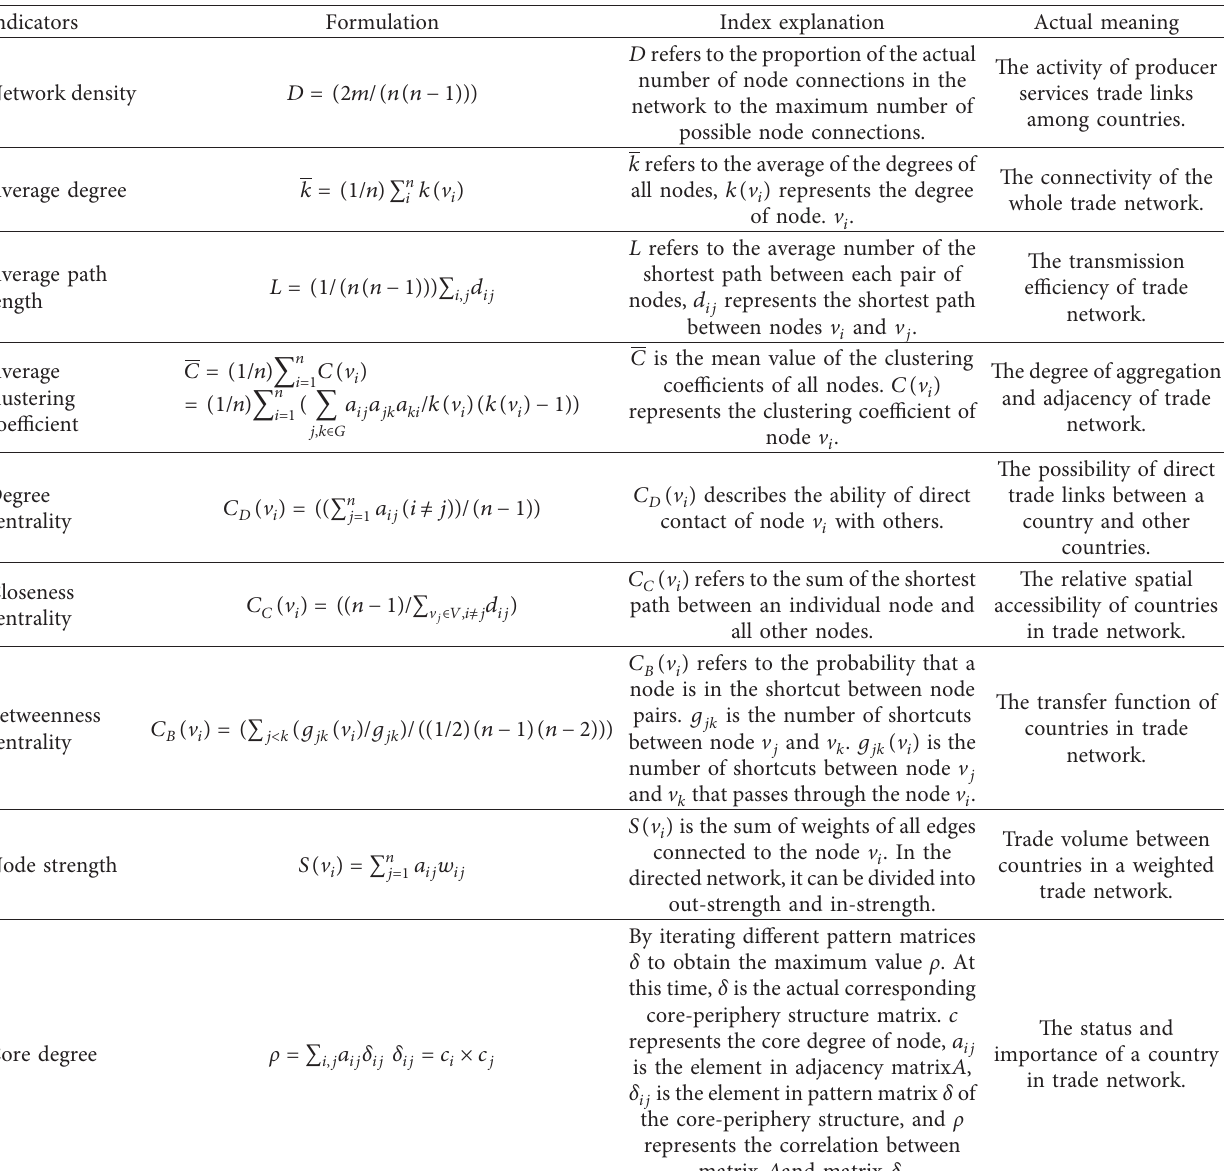
Figure 1: Logical framework. Table 1: Network analysis